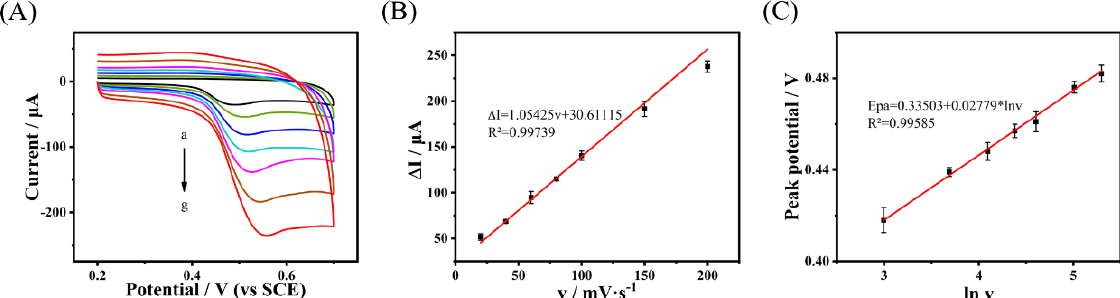
Figure 5. ( A ) CV of the Cu-H-T@rGO/GCE under the presence of 0.1 mmol·L − 1 BPA solution (in 0.2 mol·L − 1 PBS with pH = 7.0) at 20, 40, 60, 80, 100, 150 and 200 mV·s − 1 scan rates (marked as a → g). ( B ) The oxidation peak current and ( C ) peak potential as functions of scan rates ( B ) and their natural logarithms ( C ). All data points in ( B , C ) represent an average value of five measurements with the errors calculated as standard deviations.